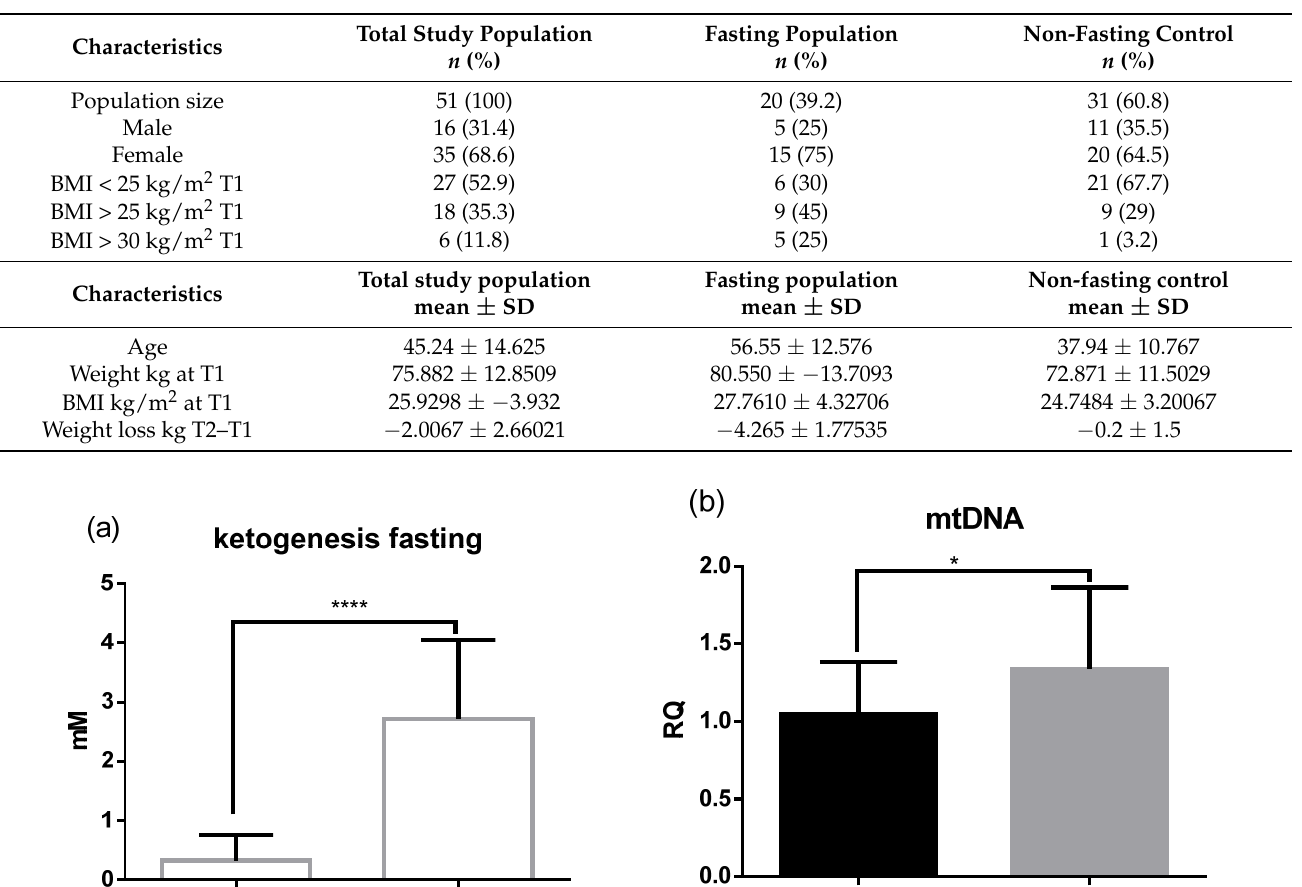
Table 1. Characterization of study population by intervention groups. Values for characterization are given in total numbers and as a percentage. Anthropometric measurements were given in mean ± SD.